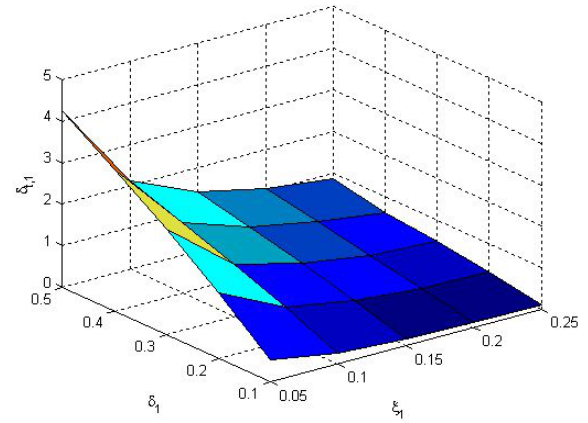
of (11) along with ,1 t d